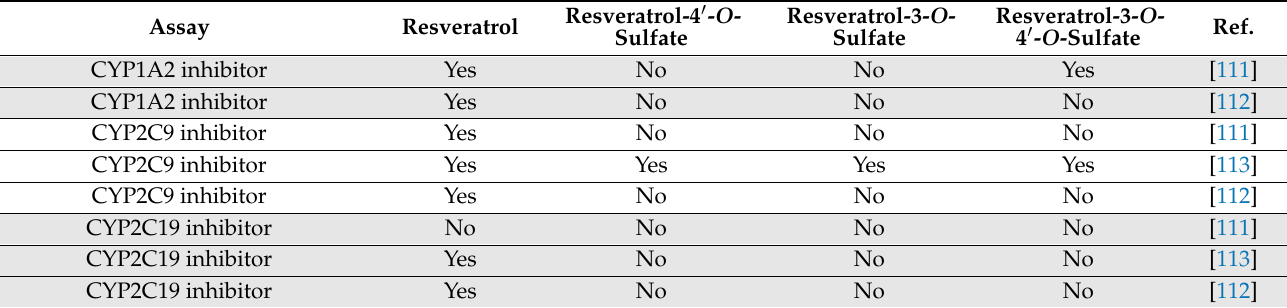
Table 2. The parameters describing the distribution, cellular uptake metabolism and interaction with receptors of resveratrol and its sulfates were calculated using freely available web-based pro- grams [111–114]. References [112–115] correspond to SwissADME, admetSAR 2.0, PreADMET, and ProTox-II,